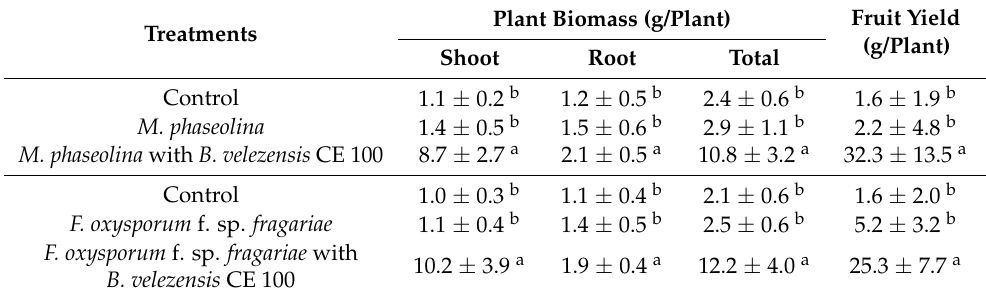
Table 1. Effects of different treatments on plant biomass and fruit yield in strawberry plants after inoculation with Macrophomina phaseolina or Fusarium oxysporum f. sp. fragariae . Plant Biomass (g/Plant) Fruit Yield Treatments (g/Plant) Shoot Root Total Control 1.1 ± 0.2 b 1.2 ± 0.5 b 2.4 ± 0.6 b 1.6 ± 1.9 b M. phaseolina 1.4 ± 0.5 b 1.5 ± 0.6 b 2.9 ± 1.1 b 2.2 ± 4.8 b M. phaseolina with B. velezensis CE 100 8.7 ± 2.7 a 2.1 ± 0.5 a 32.3 ± 13.5 a Control 1.0 ± 0.3 b F. oxysporum f. sp. fragariae F. oxysporum f. sp. fragariae with 10.2 ± 3.9 a 25.3 ± 7.7 B. velezensis CE 100